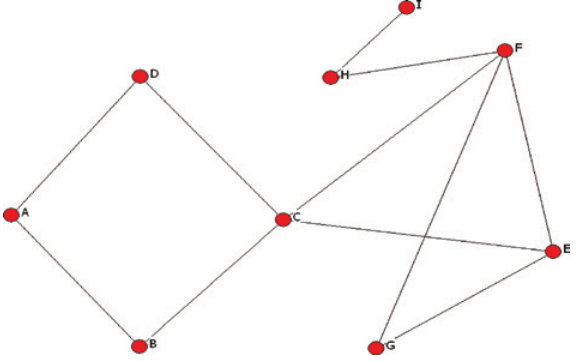
Figure 1: The relation between three patent